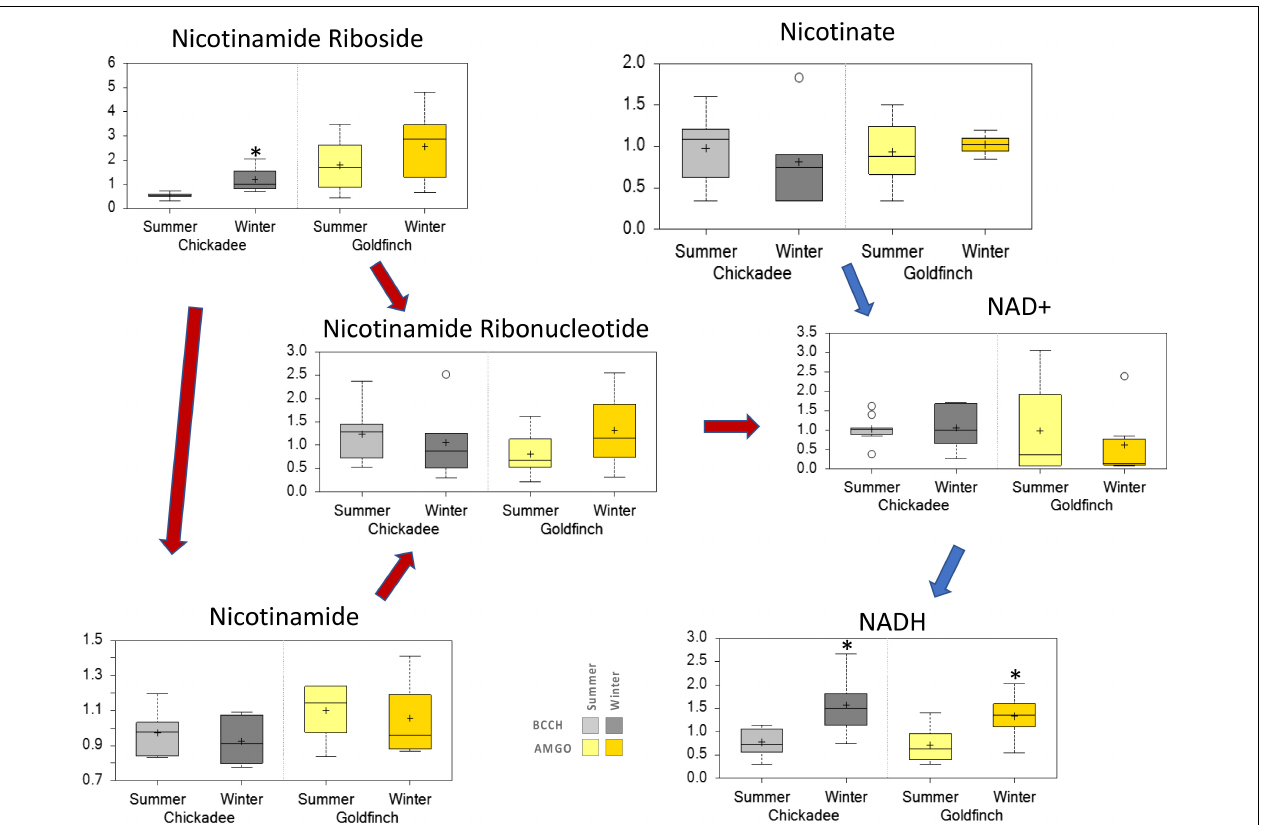
FIGURE 8 | Differences in the abundances of metabolites involved nicotinate and nicotinamide metabolism in pectoralis muscle of Black-Capped Chickadee (BCCH) and American Goldfinch (AMGO). The X -axis represents the species and the seasons sampled. The Y -axis box plots indicate the scaled intensity mean (+) and median (-) values: upper and lower ranges of boxes indicate upper and lower quartiles, respectively; upper and lower whiskers indicate the maximum and minimum distributions of the data; small circles represent outlying data points; ∗ Significantly ( p < 0.05 and q < 0.10) different compared to the other season within the species. Blue arrows—NAD + de novo via Preiss–Handler pathway; Red arrows—NAD + salvage